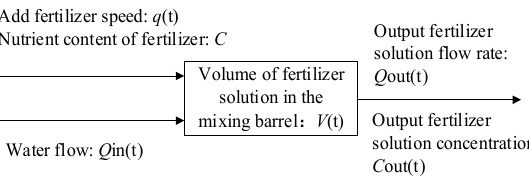
Figure 4. Dynamic model of the composting process.